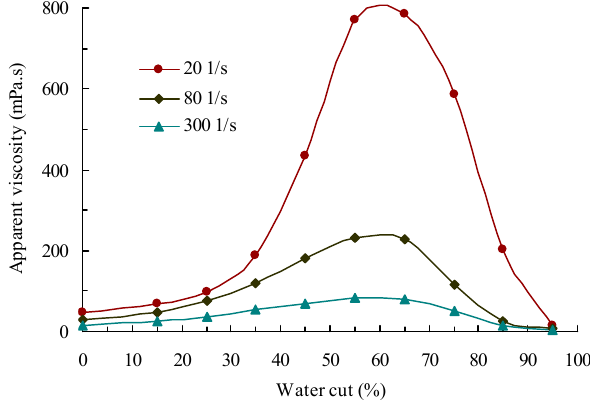
Figure 6. Phase inversion process of the waxy crude oil emulsions.